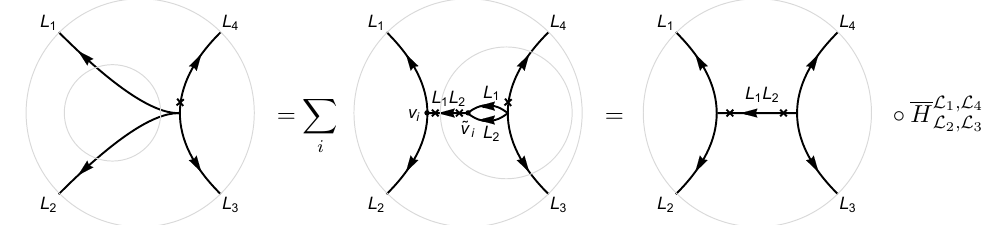
Figure 8 . The inverse map H L 1 ; L 4 . By the locality property, each graph inside each gray circle L 2 ; L 3 represents a multilinear map from the unspeci(cid:12)ed junction vectors inside the graph to the junction vector space of the lines intersecting the circle. In particular, the graph inside the smaller gray circle in the second graph represents a function that we denote by f : V L ! V . Then L 3 ; L 4 ; ( L 1 L 2 ) 1 ; L 2 ; L 3 ; L 4 e v i